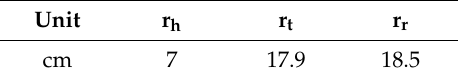
Figure 2. The actual product of an axial fan ( a ) and corresponding geometric cad model ( b ). Table 1. Dimensions of an axial fan with seven blades.